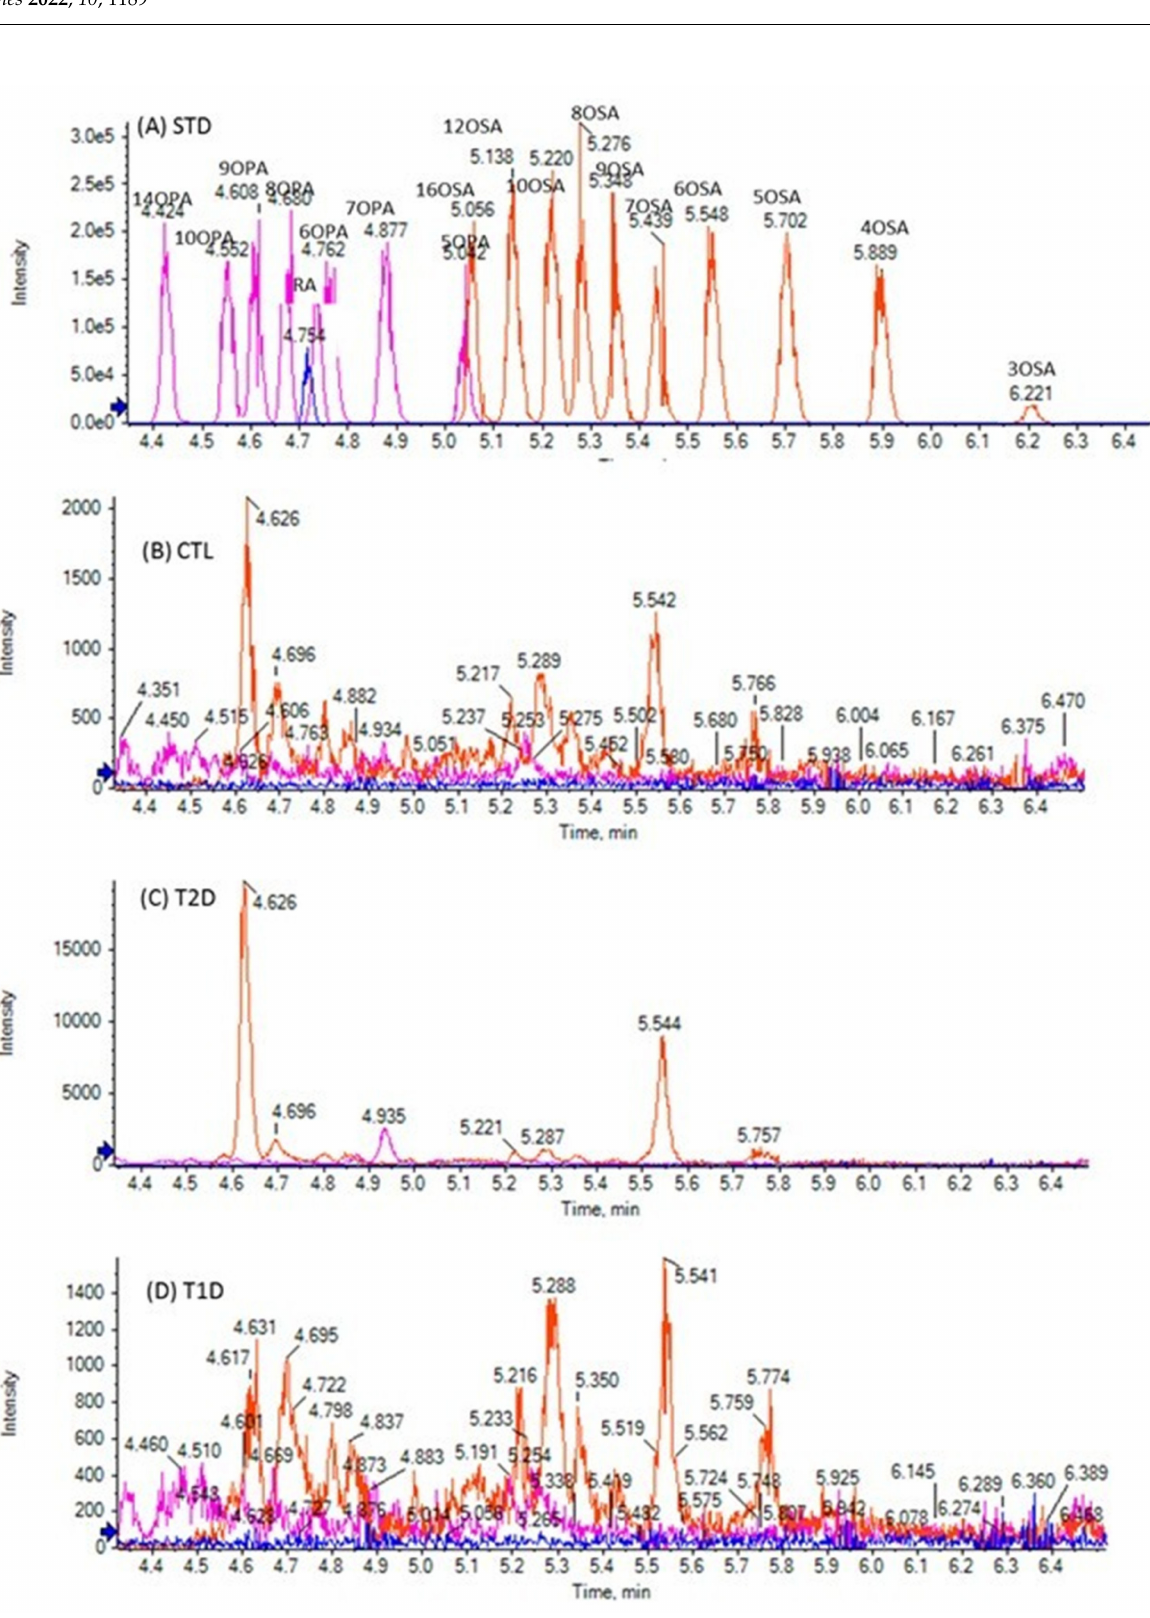
Figure 2. Extracted ion chromatograms (EICs) of SOFAs in a standard solution (500 ng/mL) ( A ), and in a representative control sample ( B ), T2D sample ( C ) and T1D sample ( D